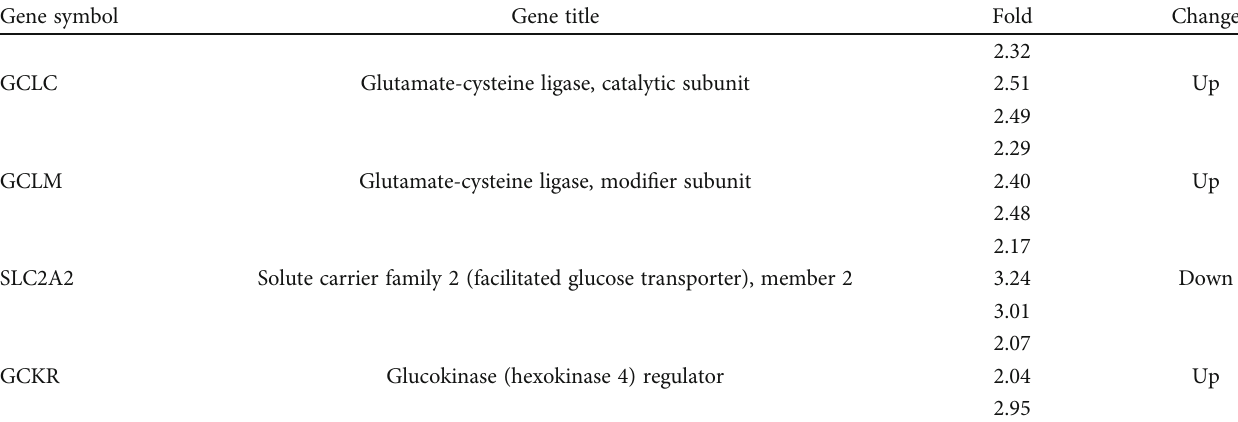
Table 4: DSs regulate the expression of genes related to glucose and lipid